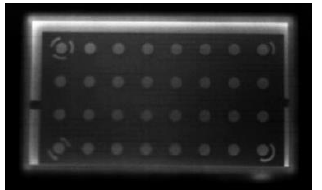
Figure 6. Thermal imagery for calibration